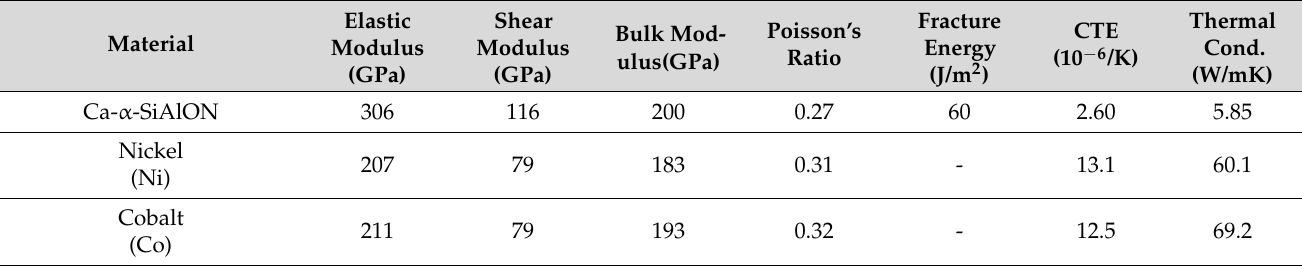
Table 1. Properties of various metal and ceramic particles used in the computation design of Ca- α - SiAlON